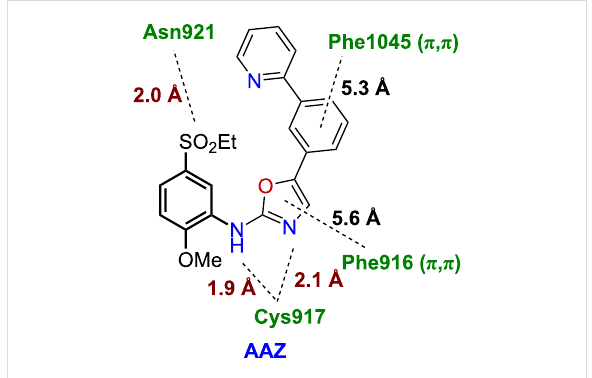
Figure 1: The AAZ ligand conformer from PDB complex 1Y6A and its VEGFR2 intermolecular interaction map depicting three hydrogen bonds and two stacked ( π , π ) interactions. No lipophilic interactions are shown here. The part of the skeleton AAZ in bold represents the frag- ment originating from the precursor 5. The interaction analysis has been performed by software Discovery Studio Visualizer 3.1 [6].